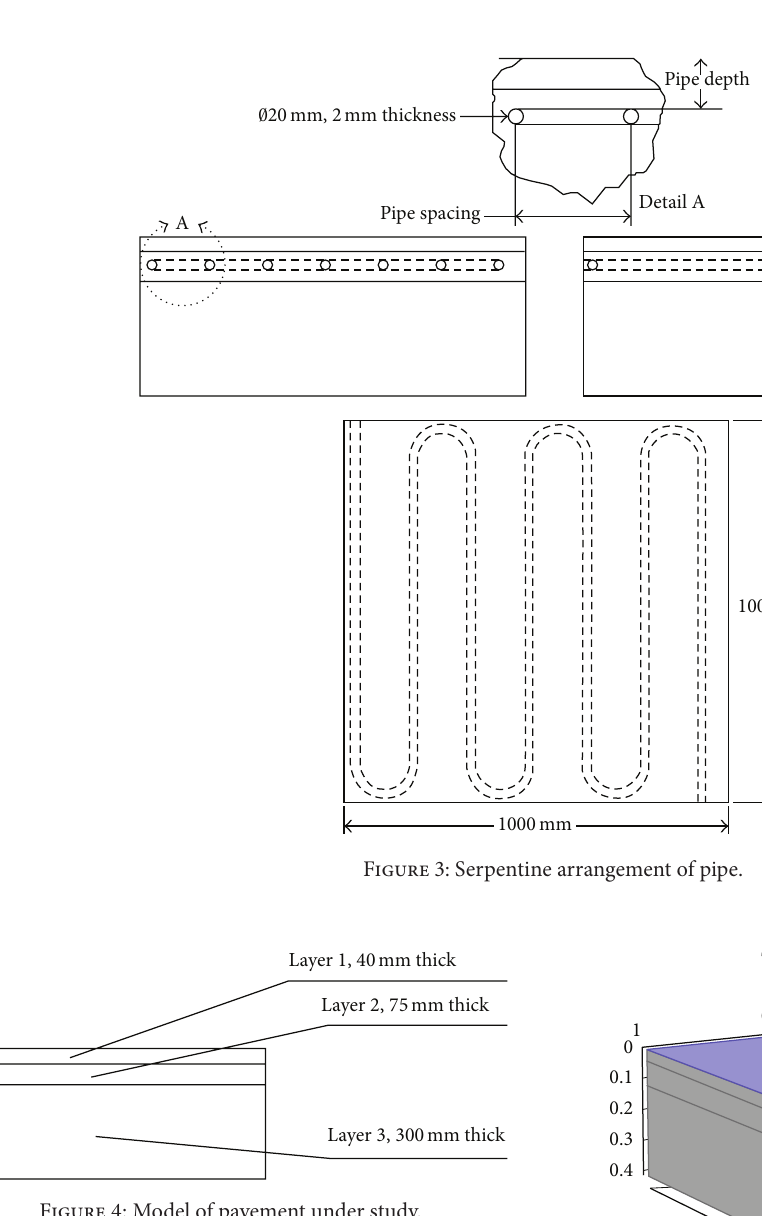
Figure 4: Model of pavement under study.